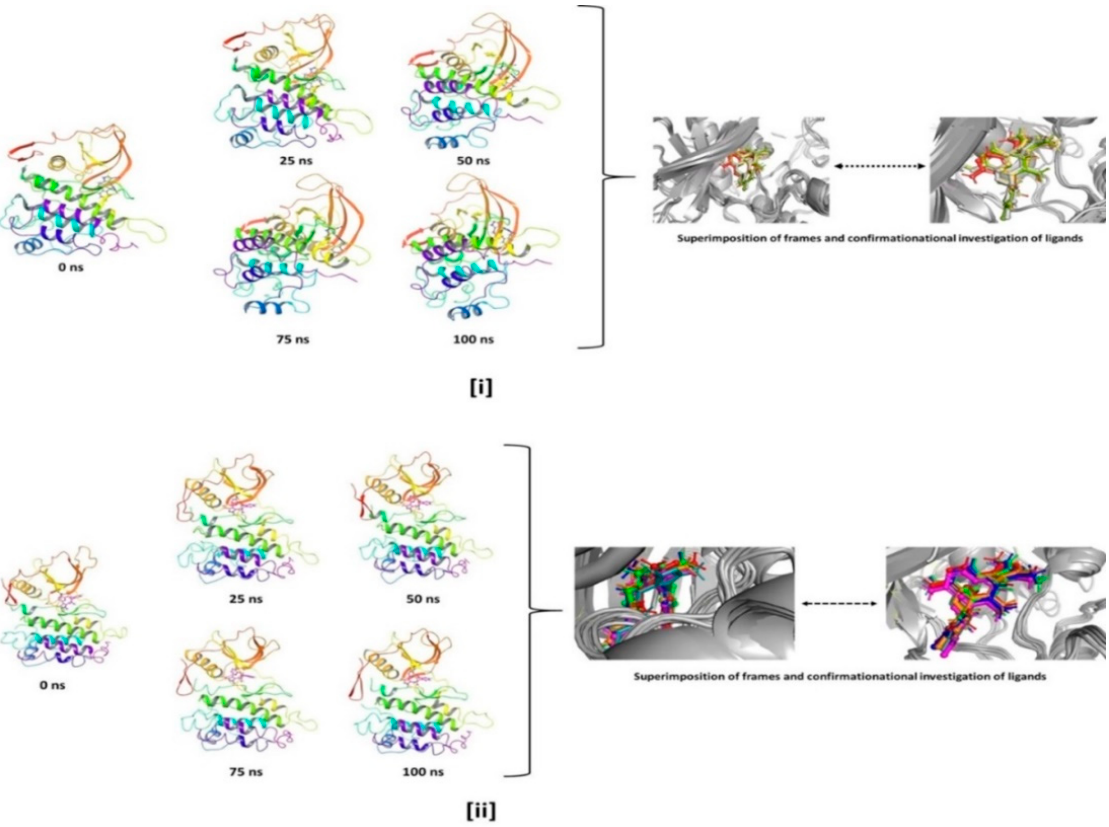
Figure 16. Stepwise trajectory analysis for every 25 ns displaying the protein and ligand confor- mation during 100 ns of simulation of [i] ALK-172 and [ii]